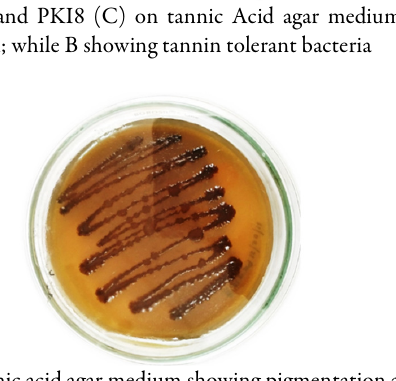
Figure 3. Growth of PKI8 on tannic acid agar medium showing pigmentation after 72 h of incubation Identification of selected bacterial strain